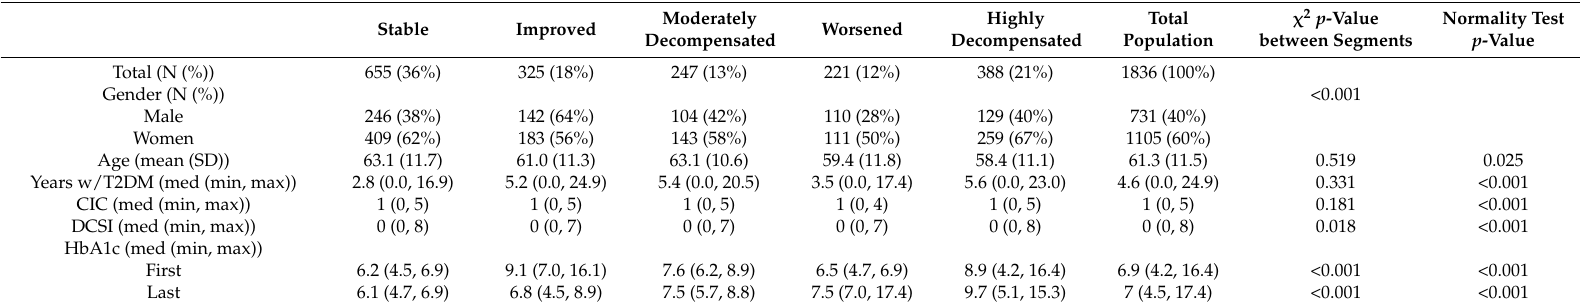
Table 2. Characterization of patients by segments and the total population of the